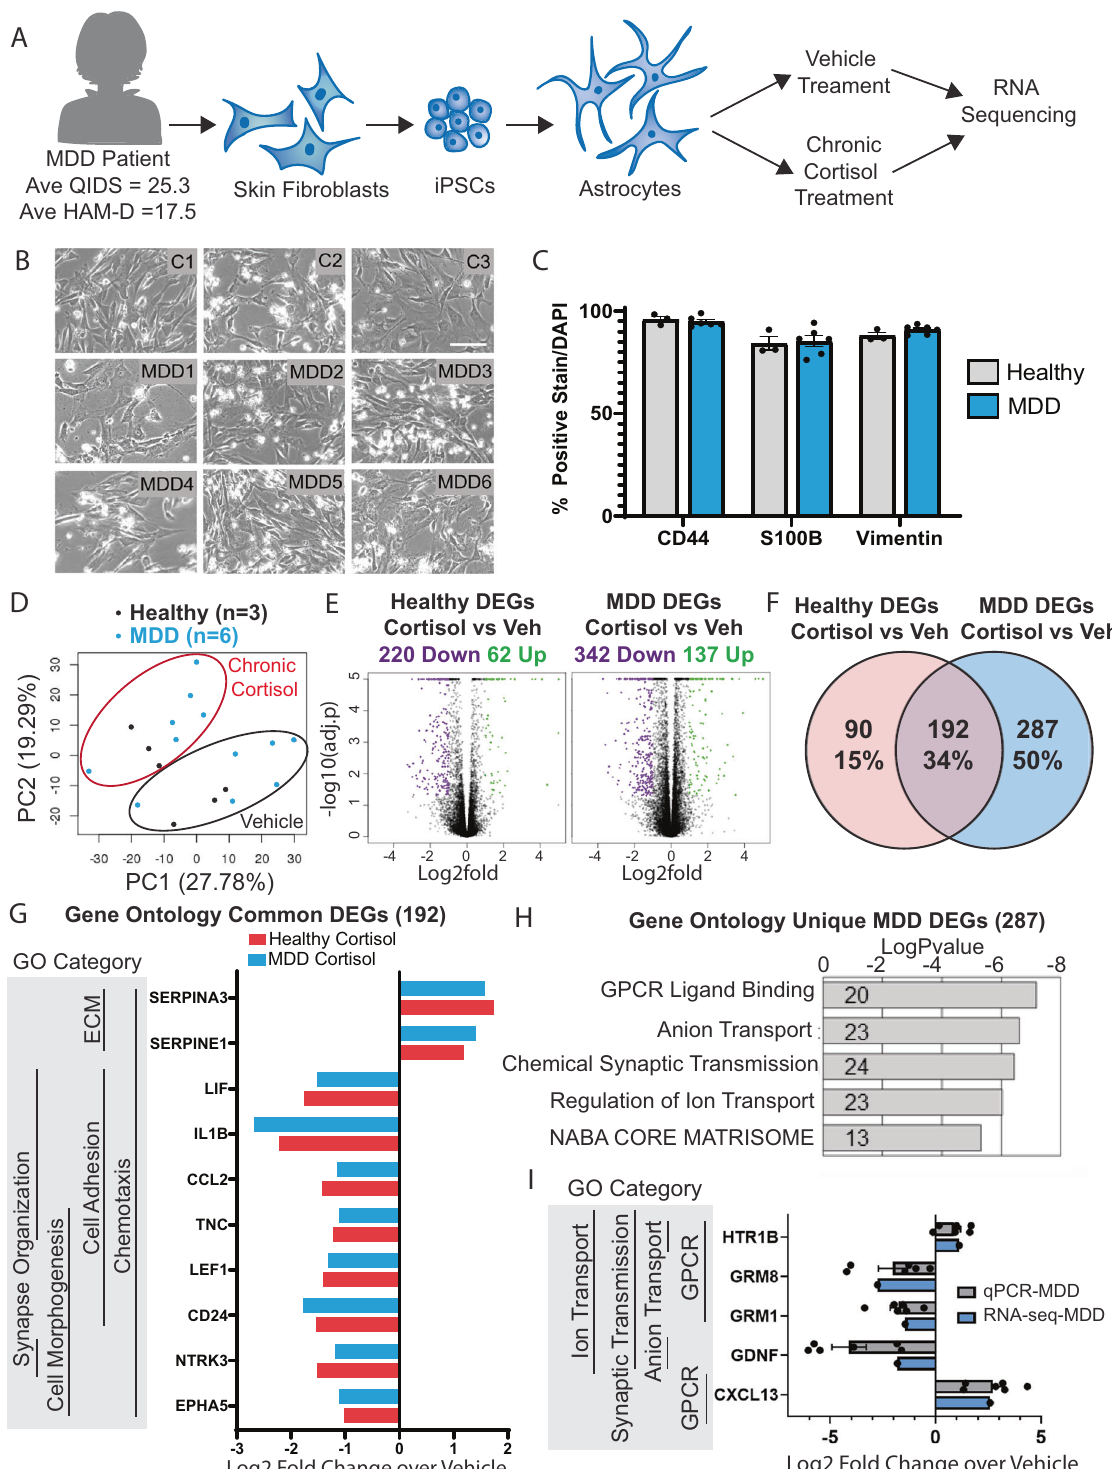
DISCUSSION Herein we present an optimized in vitro model for chronic stress in iPSC-derived astrocytes. With a serum-free protocol, we generated a homogeneous and functional population of astrocytes and identi fi